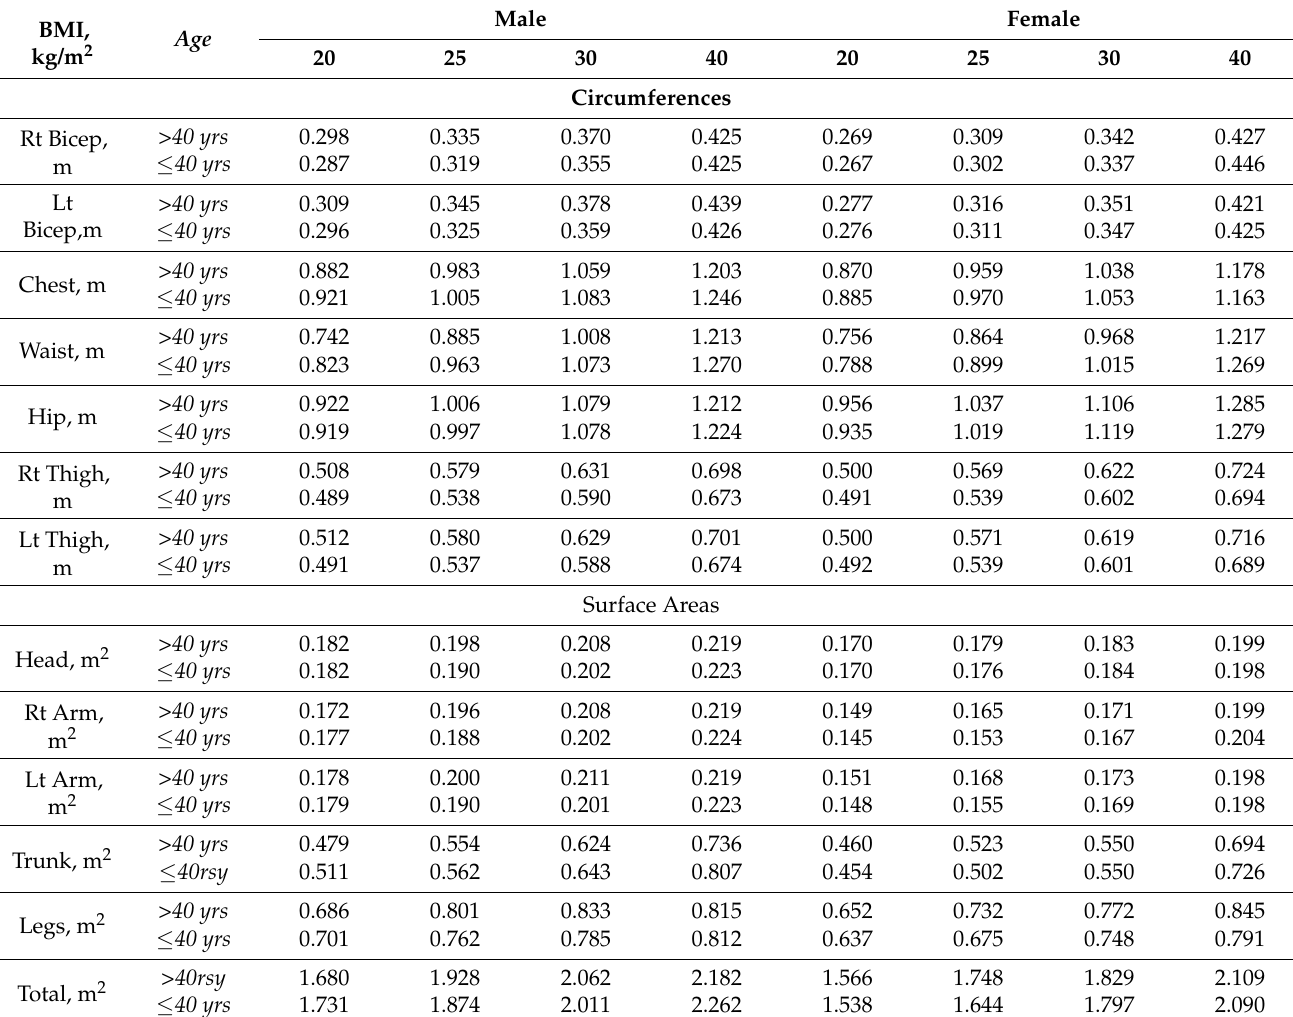
Table 3. Circumferences and Surface areas of the 2021 Reference Body for males and females according to BMI categories and age of <40 and >40 yrs. See Supplementary Material for details for the Shape Up! Adults study sample, Table